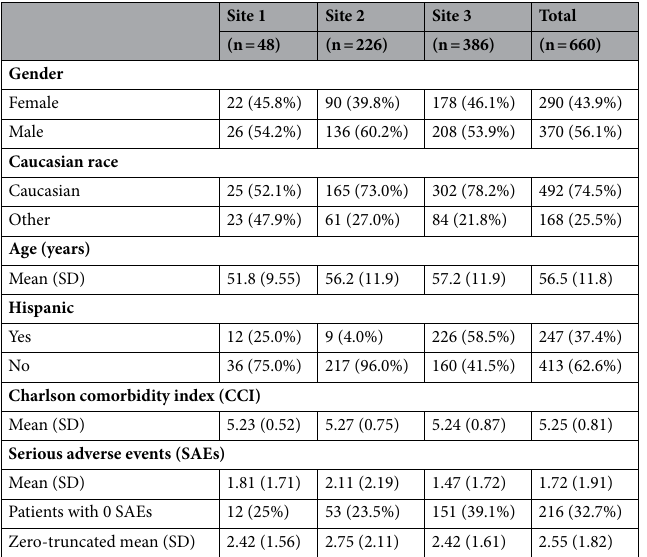
Table 3. Summary statistics describing patient population across three OneFlorida clinical